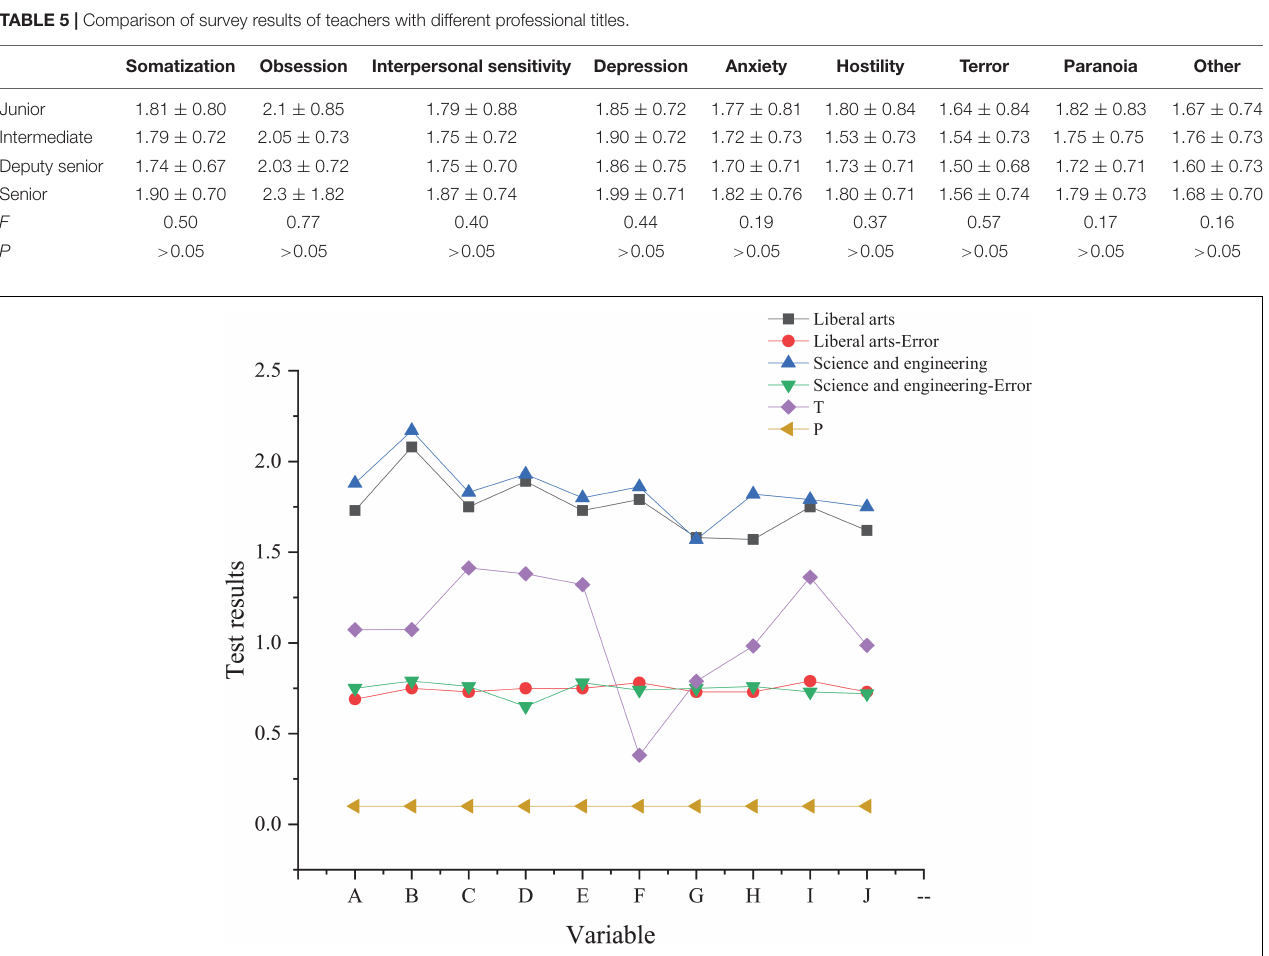
TABLE 5 | Comparison of survey results of teachers with different professional titles. Somatization Obsession Interpersonal sensitivity Depression